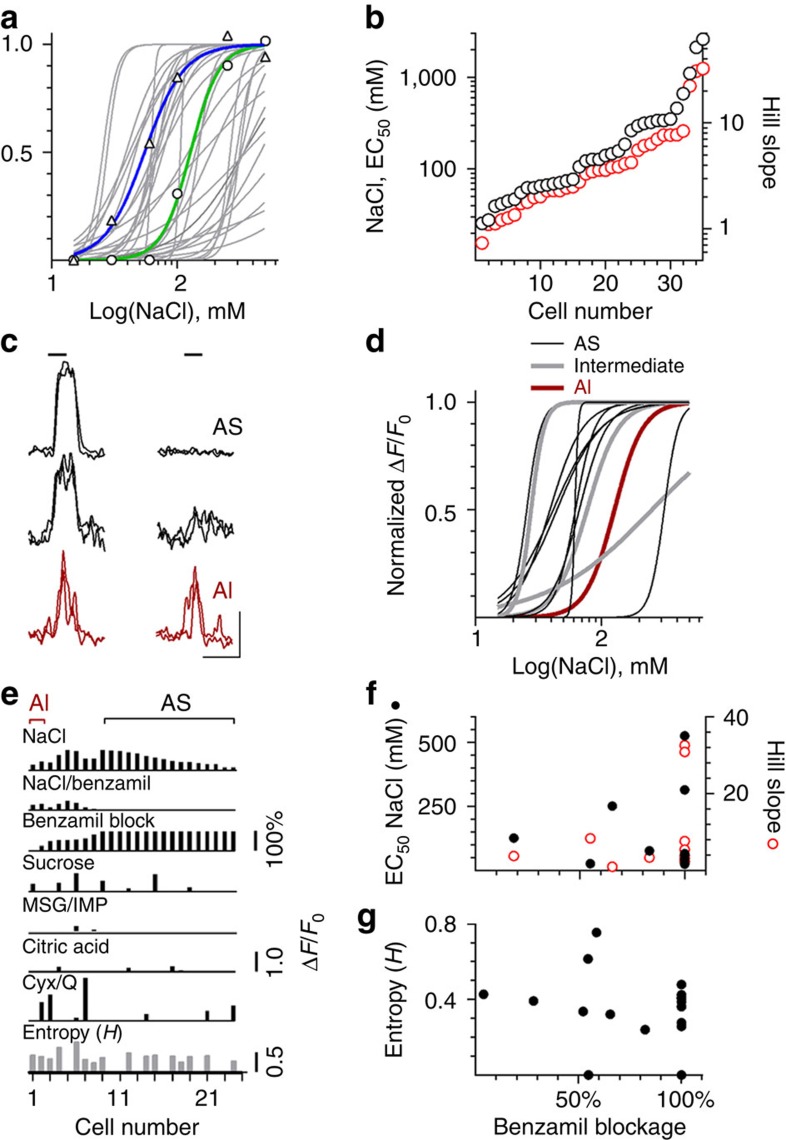
NaCl-evoked responses in geniculate ganglion neurons do not form distinct groups based on concentration-response relations or amiloride-sensitivity.(a) NaCl concentration-response relations indicate a wide range of salt sensitivities (N=35 neurons from 6 mice). Plots shown in grey are best-fit sigmoidal curves as described in Fig. 5. Two curves (blue, green) are highlighted to show typical data spread for individual cells. (b) EC50 (black symbols) and Hill slopes (red symbols) obtained from curves in a. There is no apparent grouping of NaCl sensitivities. (c) NaCl-evoked responses vary in their sensitivity to benzamil (a high-potency amiloride derivate). Bars above traces indicate oral stimulation with 250 mM NaCl. Responses from some neurons are blocked by benzamil (1 μM, top, AS, ‘amiloride-sensitive'), others are resistant (bottom, AI, ‘amiloride-insensitive') and others are only partially blocked (middle). Replicate responses from one representative cell of each type are shown. Calibration, 10 s, 0.4 ΔF/F0. (d) Concentration-response relations for neurons that were also tested for sensitivity to benzamil (1 μM). Thin black lines indicate responses that were blocked by benzamil (AS), thick grey lines show cells with intermediate sensitivity to benzamil, thick red line is a cell that was insensitive to benzamil (AI). Data are from 12 neurons, 3 mice. (e) Breadth of tuning for neurons that were also tested for benzamil sensitivity. Neurons are arranged in order of increasing sensitivity to benzamil (top 3 lines), that is, % inhibition of responses evoked by 250 mM NaCl without and with 1 μM benzamil added to stimulus solution. There is no apparent segregation of types of salt-sensitive geniculate ganglion neurons (for example, bitter- or sour-responding or breadth of tuning) based on their sensitivity to benzamil. (f) There is no correlation between benzamil sensitivity (x axis, % benzamil block of responses to oral stimulation with 250 mM NaCl) and the neuron's sensitivity to NaCl stimulation (EC50, black symbols; r=−0.154, Spearman correlation) or with Hill slopes (red symbols; r=0.175, Spearman correlation). N=13 neurons. (g) There is also no correlation between benzamil sensitivity and breadth of tuning (entropy, H) of a neuron (r=−0.330, Spearman correlation; n=24 neurons).